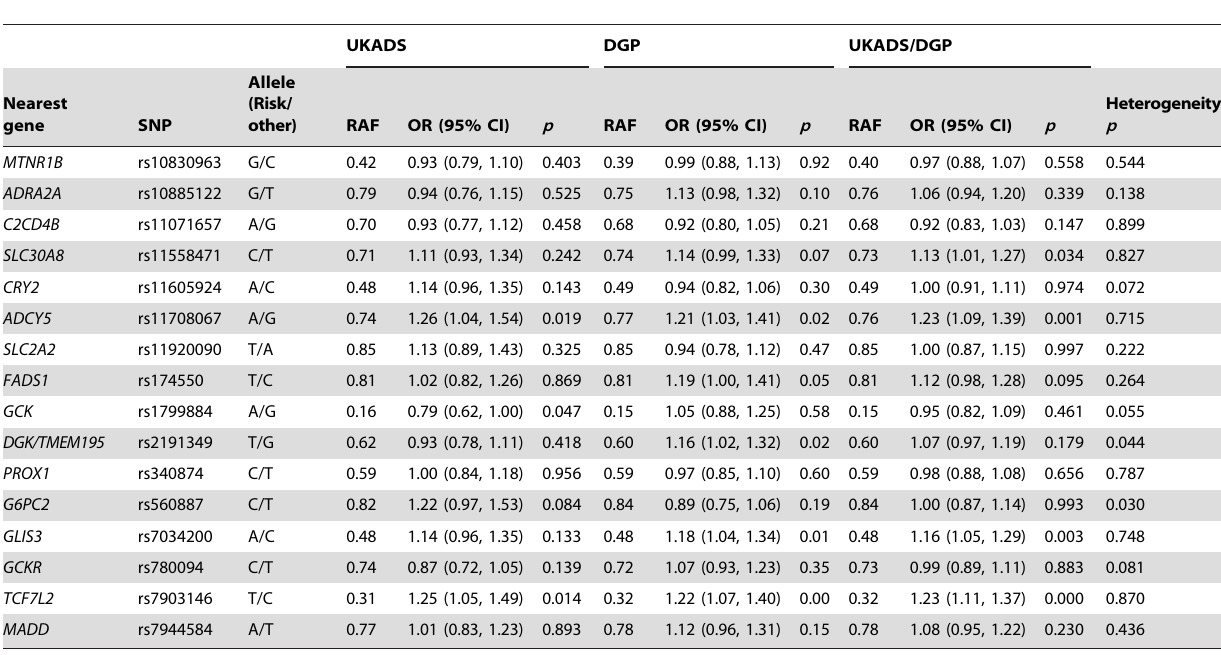
Table 2. Association of SNPs with type 2 diabetes in the UKADS and DGP study